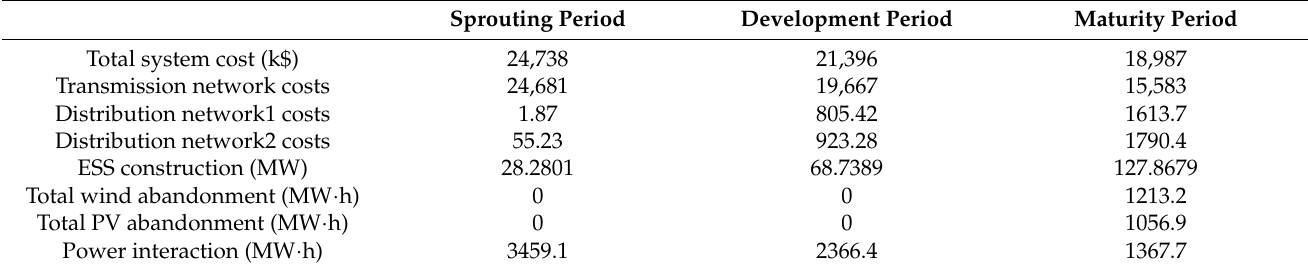
Table 7. Comparison of transmission and distribution collaborative planning/transmission and dis- tribution separation planning strategy.